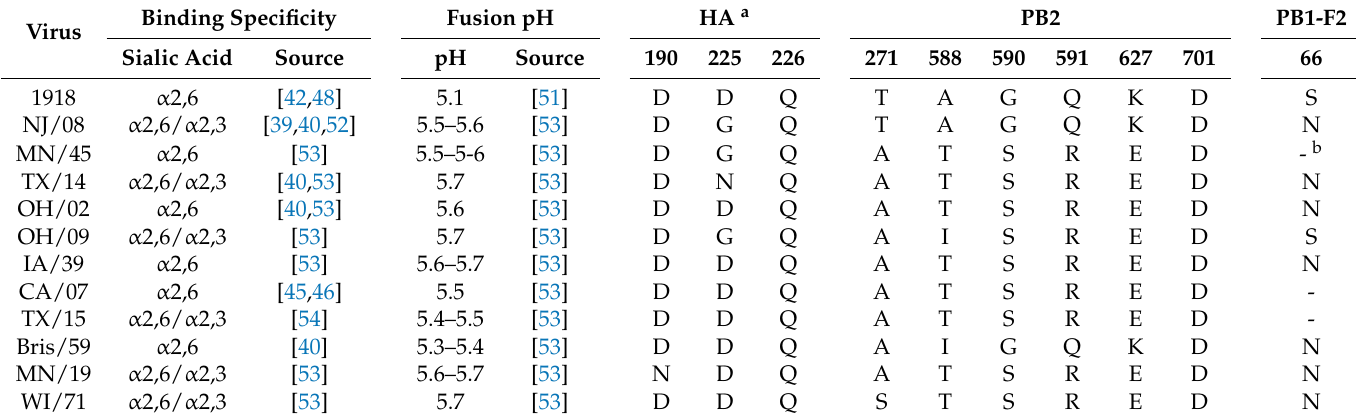
Table 2. Receptor binding specificity, HA activation pH, and molecular markers of H1 influenza